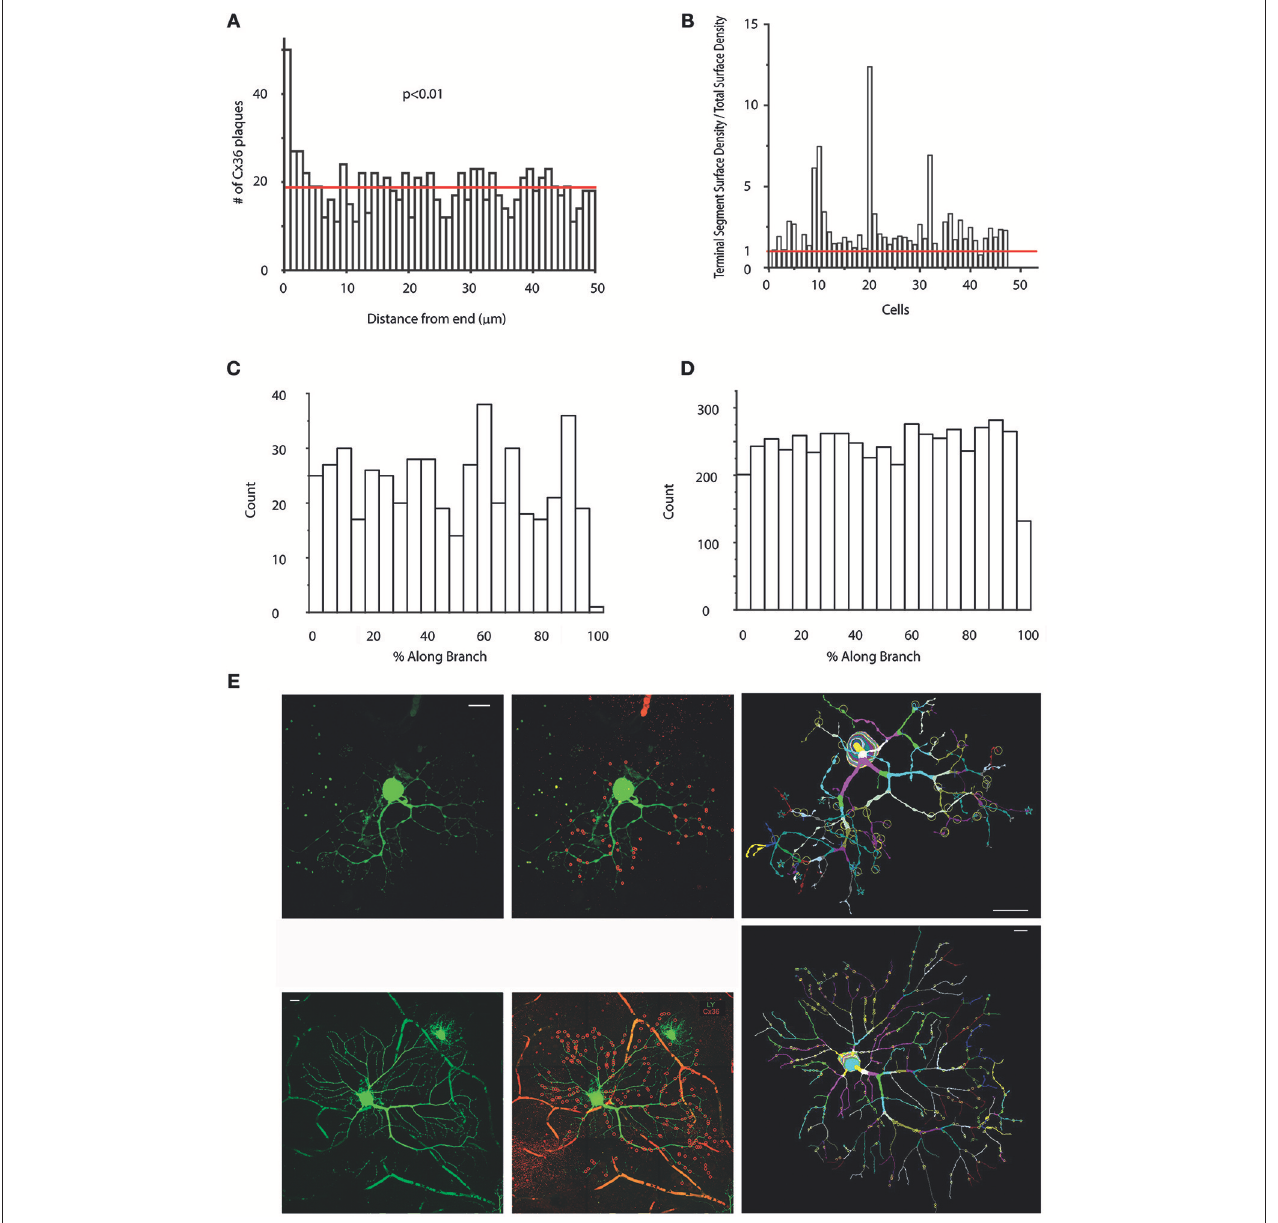
FIGURE 5 | Preferred Cx36 plaque locations in hRGC dendritic arbors. (A) Histogram showing the numbers of Cx36 plaques located at only terminal segments as a function of the distance from the ending. Note, that only terminal segments with lengths > 50 µ m (shorter segments would skew the analysis toward the lower values) were selected for this analysis (the red line marks the mean). Clearly Cx36 plaques located at terminal dendritic segments prefer sites that are close to the very endings (Wilcoxon signed-rank test). (B) Histogram shows the “Terminal Segment Surface Density/Total Surface Density” ratio for cells in this study (x axis) to reveal if terminal endings are preferred sites for Cx36 plaques. It can clearly be seen that the terminal segment density is higher than the overall density (red line) in case of most (44 out of 47) cells (see also length and volume density charts in Supplemental Figure 3 ). (C,D) Graphs display Cx36 plaque counts as a function of the percentage of total length (distance from proximal branch-point/total segment length *100) of their respective dendritic segment for one representative hRGC (C) and all cells in the sample (D) . Note, that these analyses contain only non-terminal segments, whereas previous analyses in (B) examined only terminal segments. Cx36 plaques with lower values are located in the vicinity of proximal end of the segment (end closer to the soma) whereas Cx36 plaques with high values are close to distal branch points (end farther from the soma). We found that both individual histograms and the combined histogram displays no sign of any favored segment locations for Cx36 plaques. (E) Two representative hRGCs (left panels) maintaining many Cx36 plaques (red circles in the middle panels and letter marks in the right panel; red circles mark only colocalized Cx36 plaques that were confirmed in Neurolucida reconstructions) over their dendritic arbor. Many colocalizing Cx36 plaques were located near to the terminal endings as shown in both the photograph (middle) and the corresponding Neurolucida reconstruction (right) for both neurons. The cell on the bottom displays a soma-dendritic morphology reminiscent of parasol (M) hRGCs based on previous descriptions by Kolb et al. (1992) Scale bars: 25 µ m.